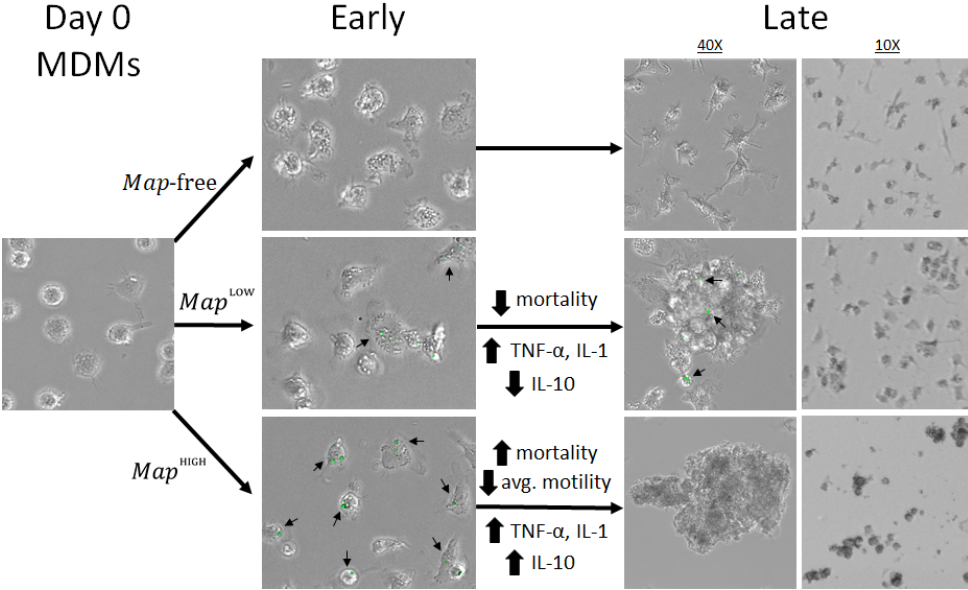
Figure 8. Schematic summary of the findings of this model. Map bacilli stained with CFSE (green) and marked with arrows.